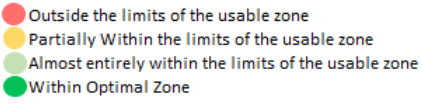
Figure 7. Color scale adopted in the analysis.